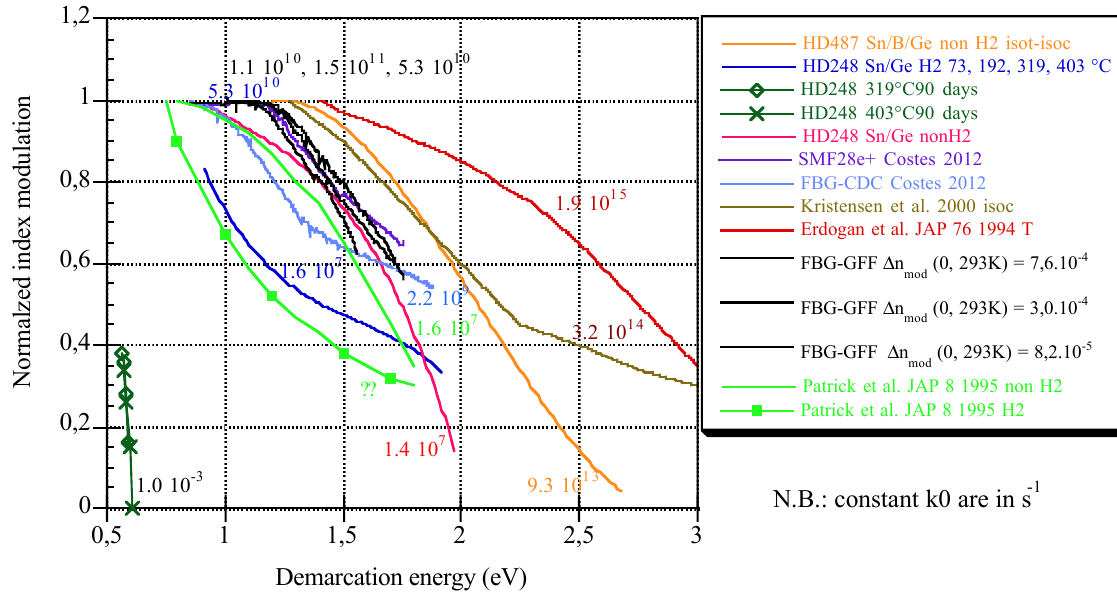
Figure 41. Shape of the stability function of a normalized index for different experimental